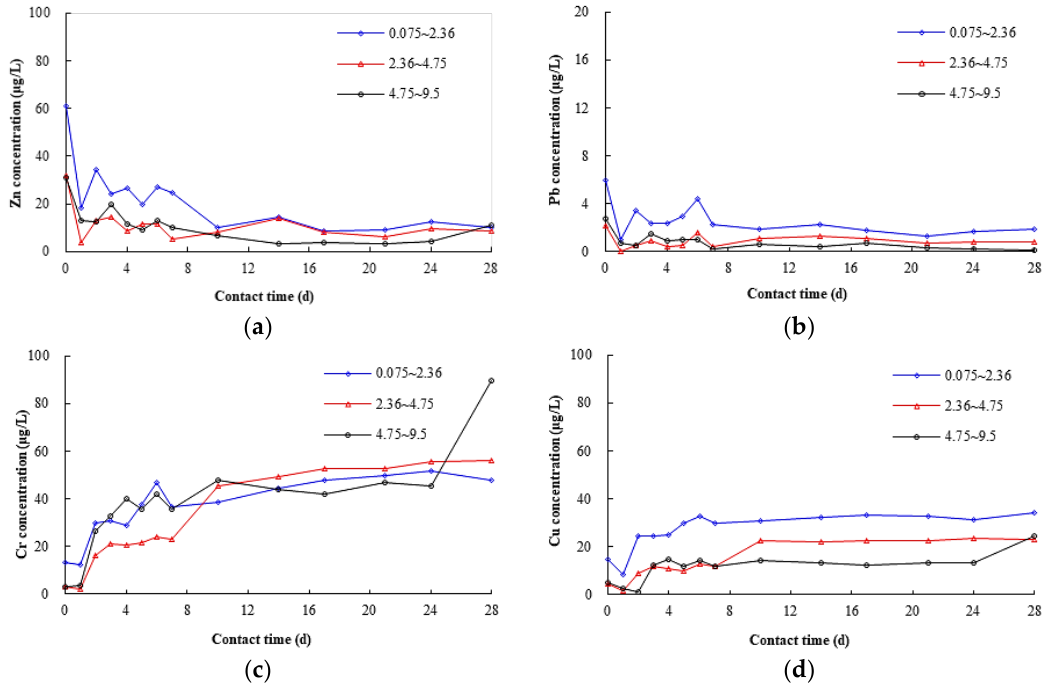
Figure 4. Variation of leaching concentrations of each heavy metal with contact time for MSWI-BAA: ( a ) Zn; ( b ) Pb; ( c ) Cr; and ( d ) Cu.